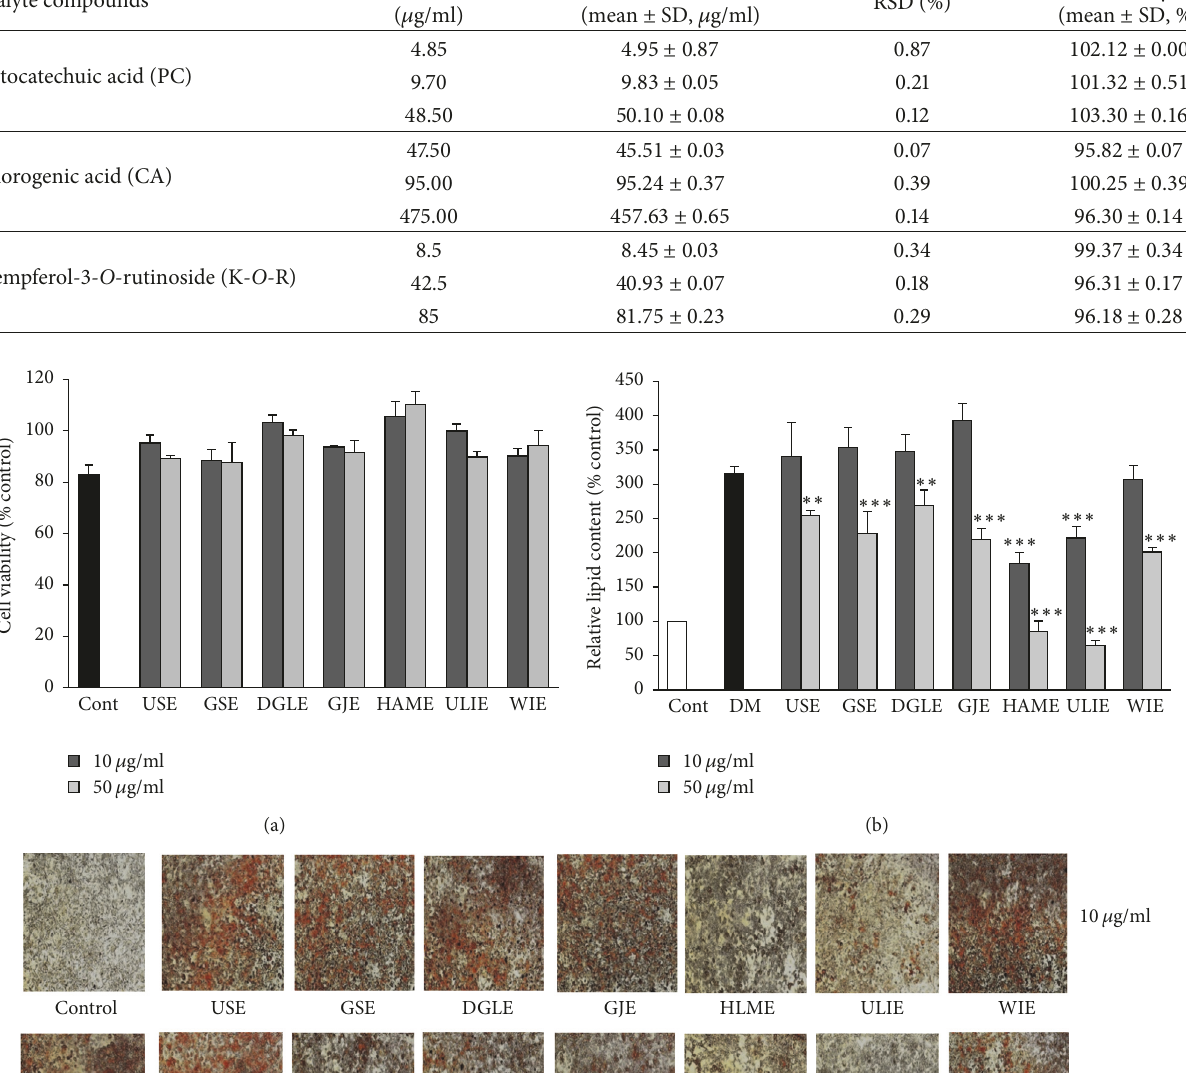
Table 3: Recovery of protocatechuic acid, chlorogenic acid, and kaempferol-3- O -rutinoside. Analyte compounds